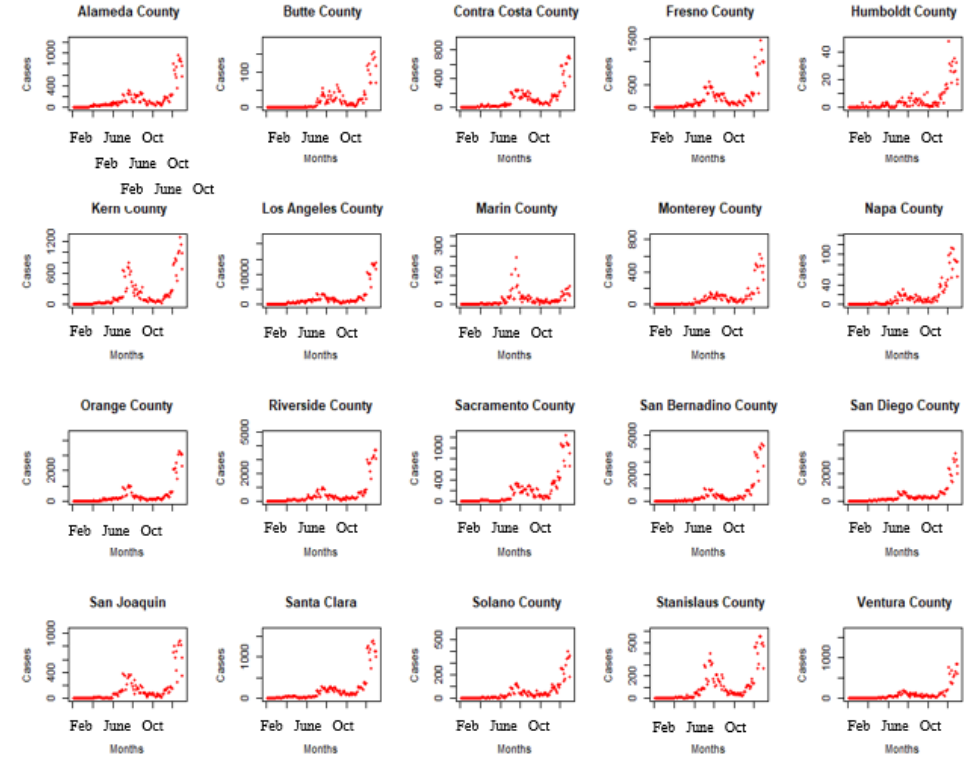
Figure 2. Time series of confirmed COVID-19 cases in the 20 counties during the study period.